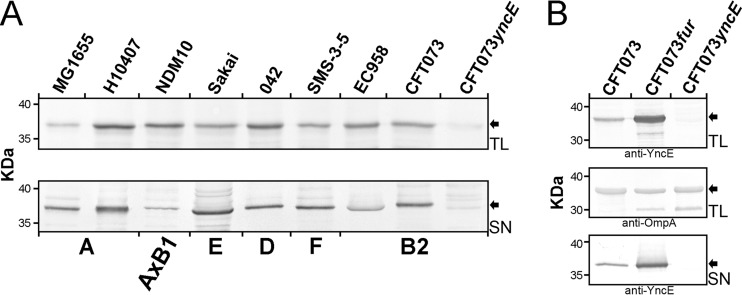
Western blot analysis of total cell lysate (TL) and supernatant (SN) fractions prepared from E. coli strains representing different phylogroups. (A) The YncE protein was detected in all TL and SN samples. The specificity of the antiserum was confirmed by the absence of a cross-reacting band in the CFT073 yncE mutant. (B) Overexpression of YncE in a fur knockout mutant. OmpA was used as an expression control.